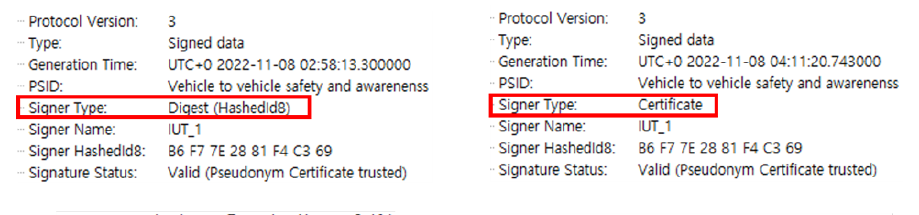
Figure 17. The verification node checks the signer type of the BSM sent by the evaluation target node. When an event occurs, the signer type must be “certificate”. If it is “digest”, the verdict is “fail”. The figure on the left shows an event occurred but the signer type is “digest”, and the result is “fail”. The figure on the right shows that the signer type is “certificate” when an event occurs, and the result is